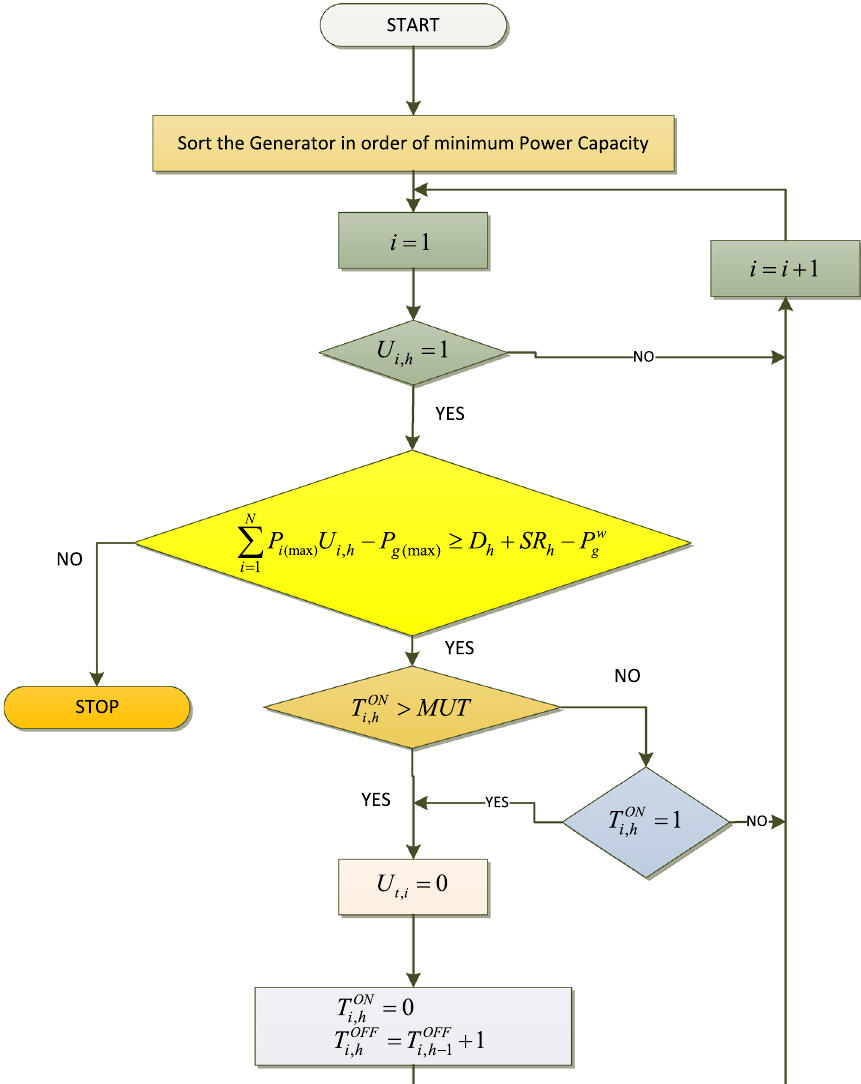
Fig. 3 Flowchart for the de-commitment of excessive generating